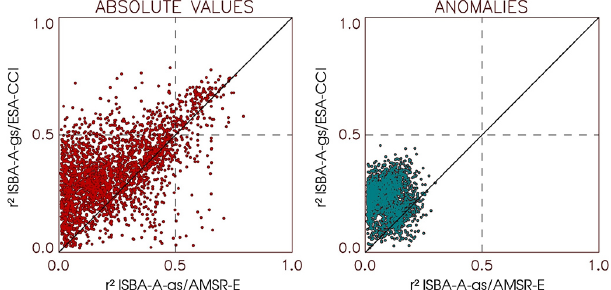
Figure 5. Detrended SSM ESA-CCI vs. AMSR-E, (left panel) abso- lute and (right panel) anomaly squared correlation coefficients ( r 2 ) with the detrended ISBA-A-gs SSM, over the 2003–2008 period. Note that r 2 values are plotted for grid cells corresponding to posi- tive r values,